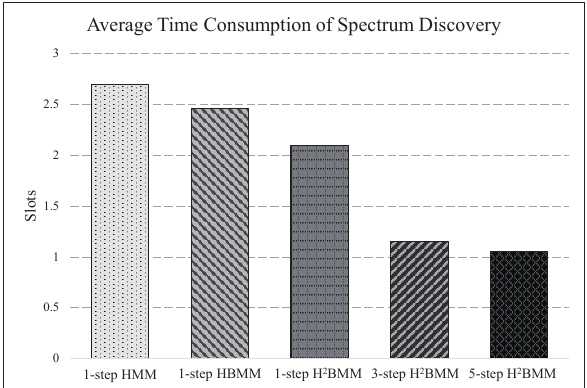
Figure 10. Time Consumption of HMM, HBMM and H 2